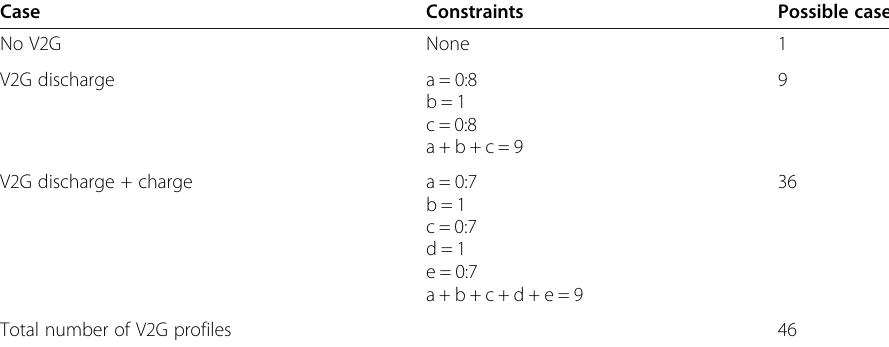
Table 3 Number of possible V2G profiles in the V2G window Case